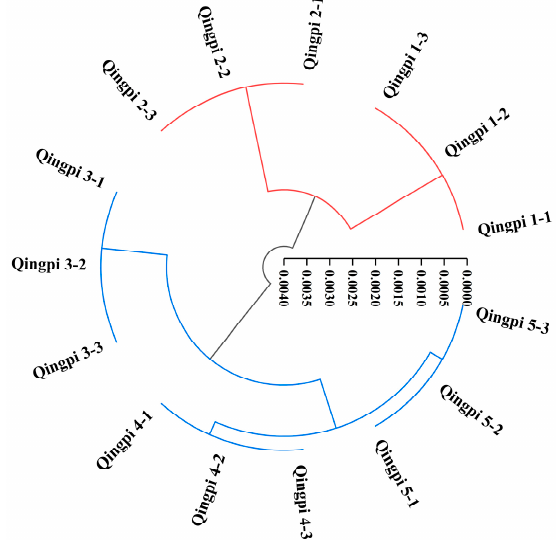
Figure 3. Hierarchical cluster analysis of Qingpi 1, Qingpi 2, Qingpi 3, Qingpi 4, and Qingpi 5 samples during 1, 2, 3, 4, and 5 years of storage, respectively, based on the color parameters.